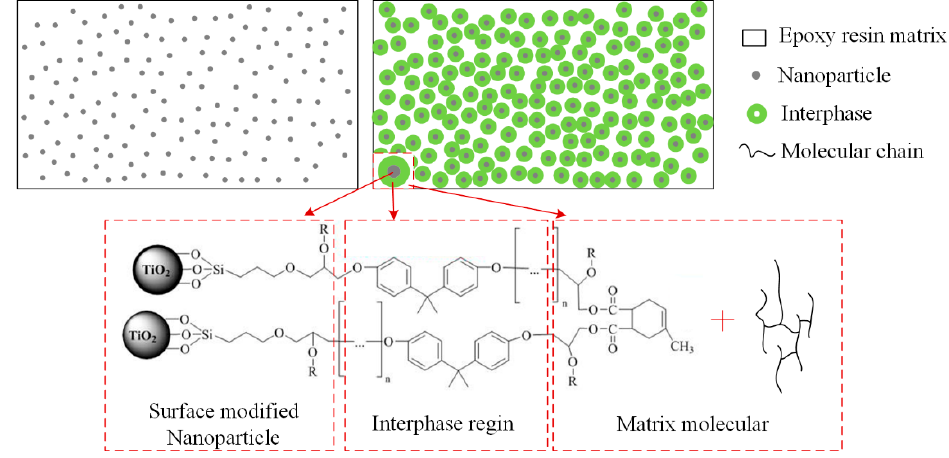
Figure 10. Absorption currents of epoxy/TiO 2 samples.